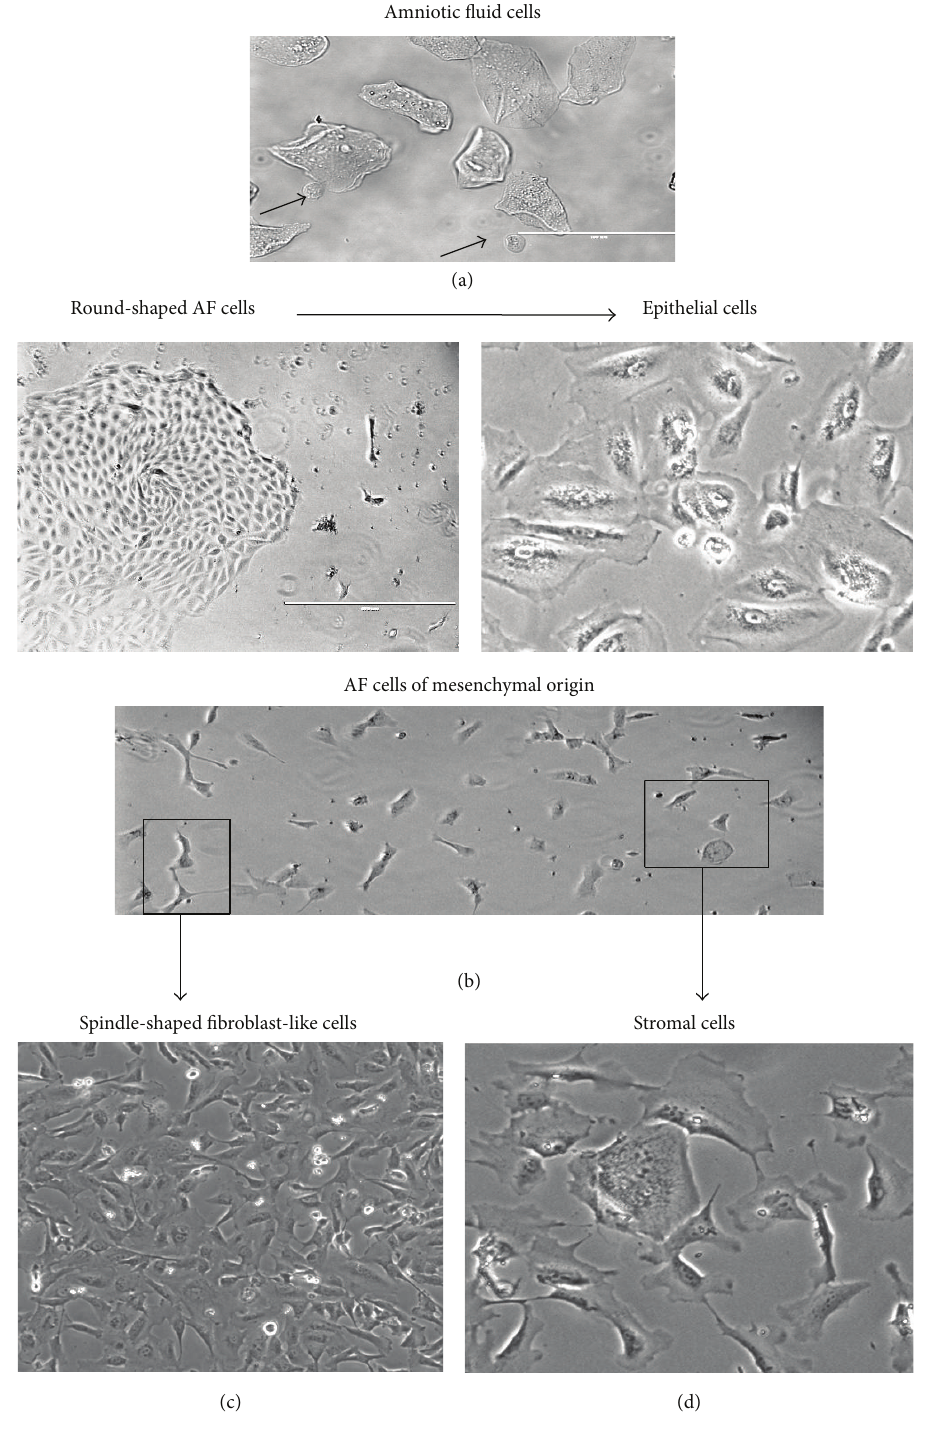
Figure1:MorphologicalcharacteristicsofAFcells.(a)Amnioticfluidcellsfromamniocentesissample.(b)Thecolonyappearanceofepithelial type at 10–15 days after initiation of the primary culture and the expansion of epithelial cell population at passage 3. (c, d) Mesenchymal-type cells in the primary culture at 10–15 days and after culturing to elongated spindle-shaped or flat “stromal” cell populations at passage